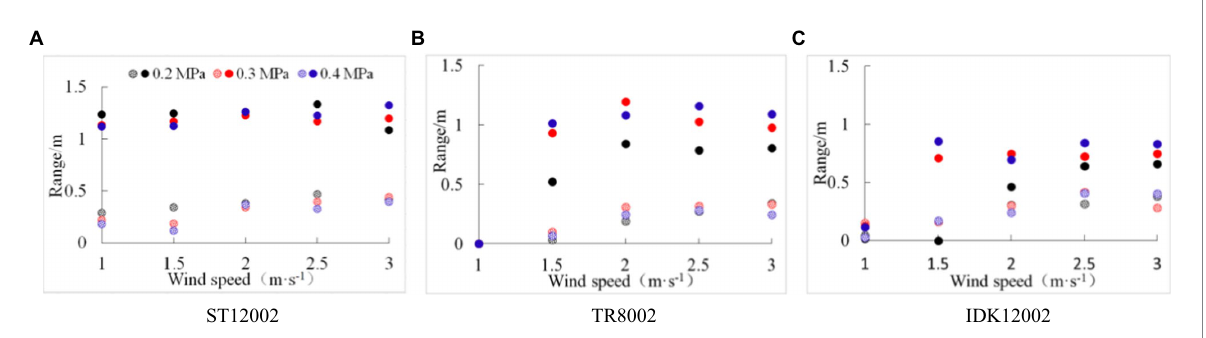
FIGURE 5 Width and height range of drift point distributions scanned by the LiDAR sensor for the three nozzles. The circles filled with solid color represent the width range in the horizontal direction and the circles filled with dotted point represent the height range in the vertical direction. (A) ST12002. (B) TR8002. (C)